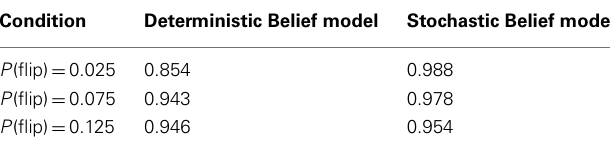
Table 3 | Choice performance relative to deterministic